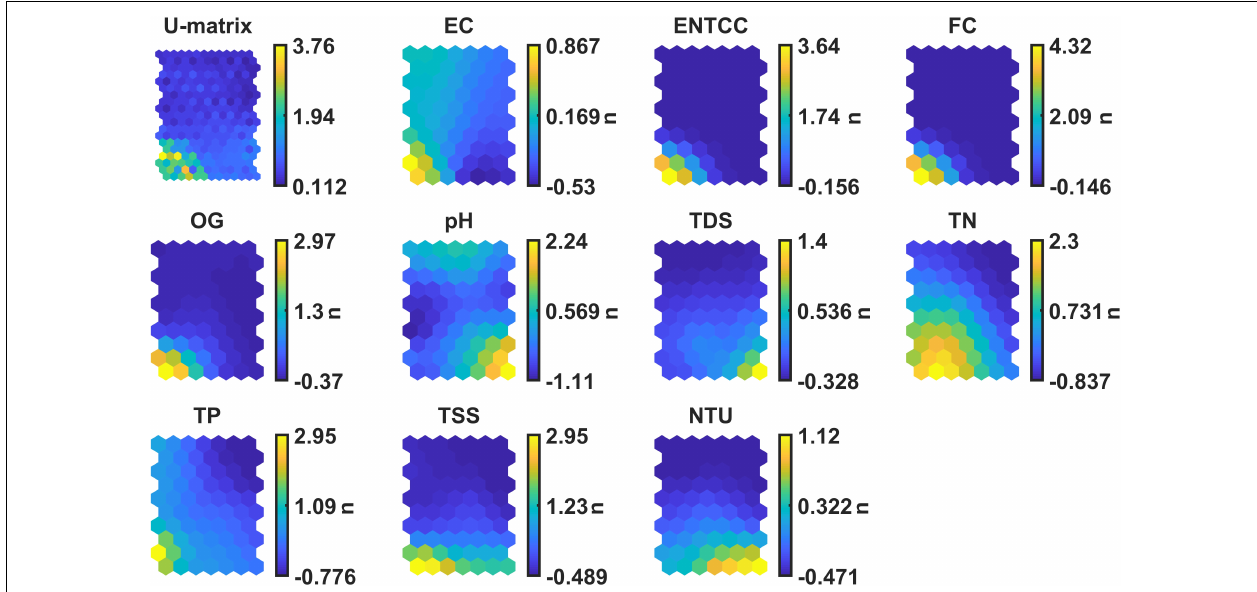
FIGURE 2 | SOM component planes of all parameters, electrical conductivity (EC), enterococci (ENTCC), fecal coliform (FC), oil and grease (OG), pH, total dissolved solids (TDS), total nitrogen (TN), total phosphorus (TP), total suspended solids (TSS), and turbidity (NTU). Dark color indicates low values and light color means high values. n indicates that the data was